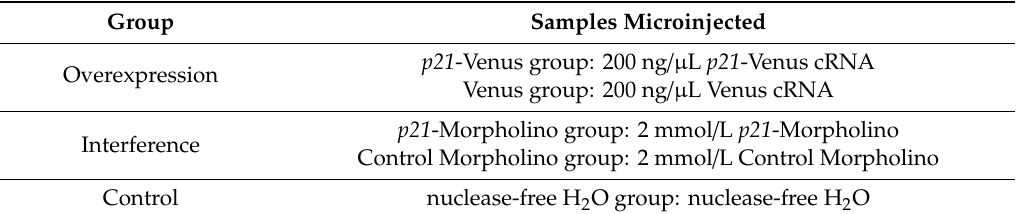
Table 1. Microinjection into germinal vesicle (GV)-stage oocytes for overexpression or interference of p21